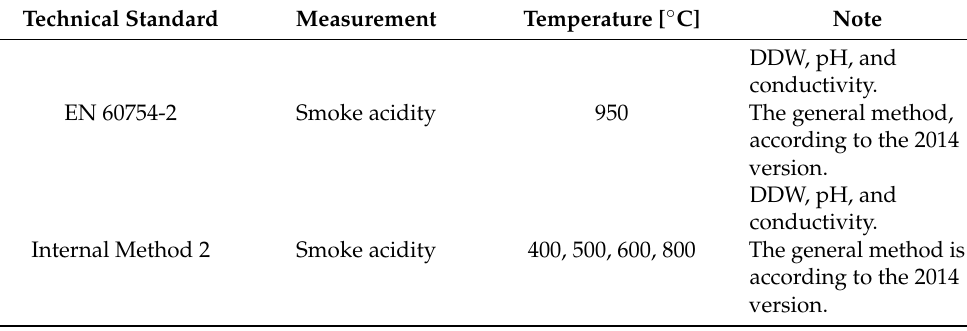
Table 6. Tests for acidity